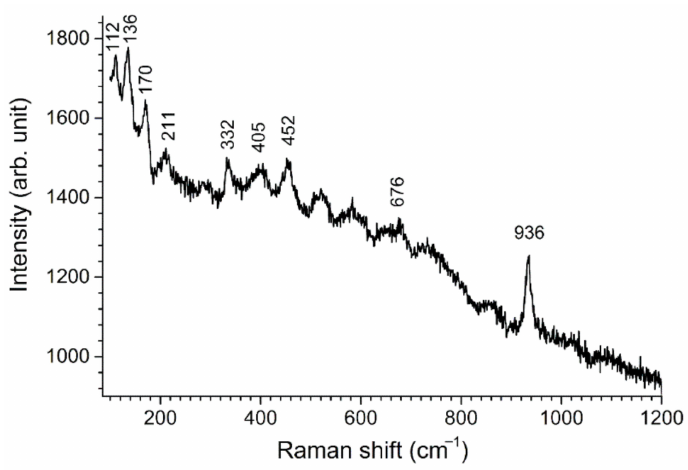
Figure 10. µ -RS analysis of the Zn-2-coated electrode surface after the 6-month galvanic corrosion experiment.